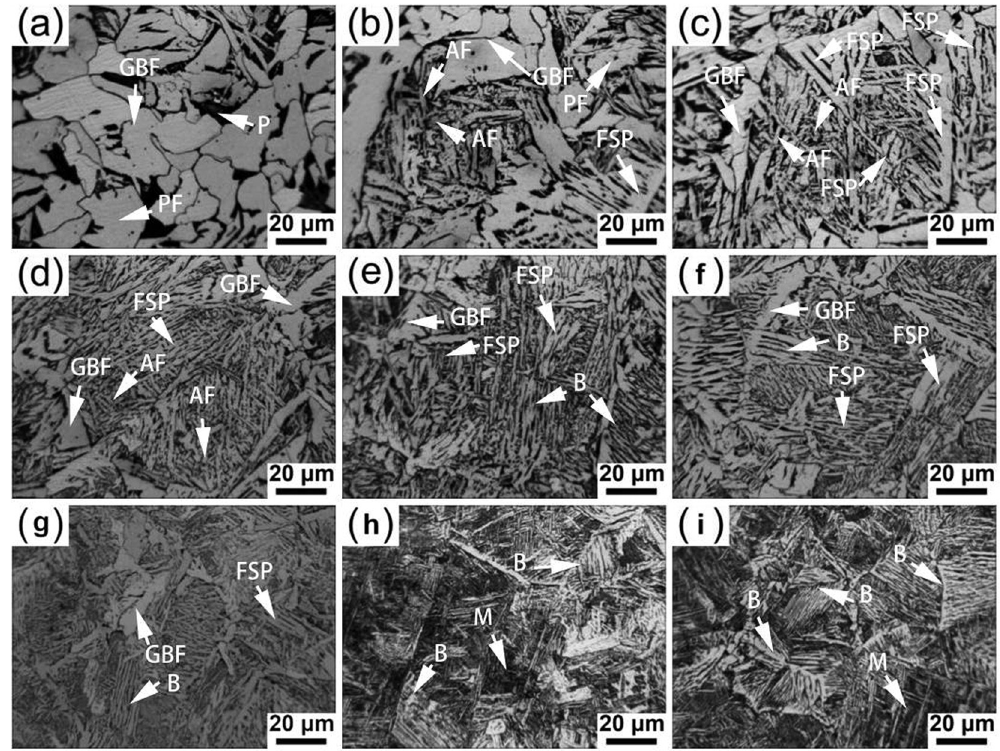
Figure 4: The microstructures of steel no. 3 cooled by different rates. ( a ) 1°C/s, ( b ) 2°C/s, ( c ) 3°C/s, ( d ) 5°C/s, ( e ) 8°C/s, ( f ) 10°C/s, ( g ) 15°C/s, ( h ) 25°C/s, and ( i )